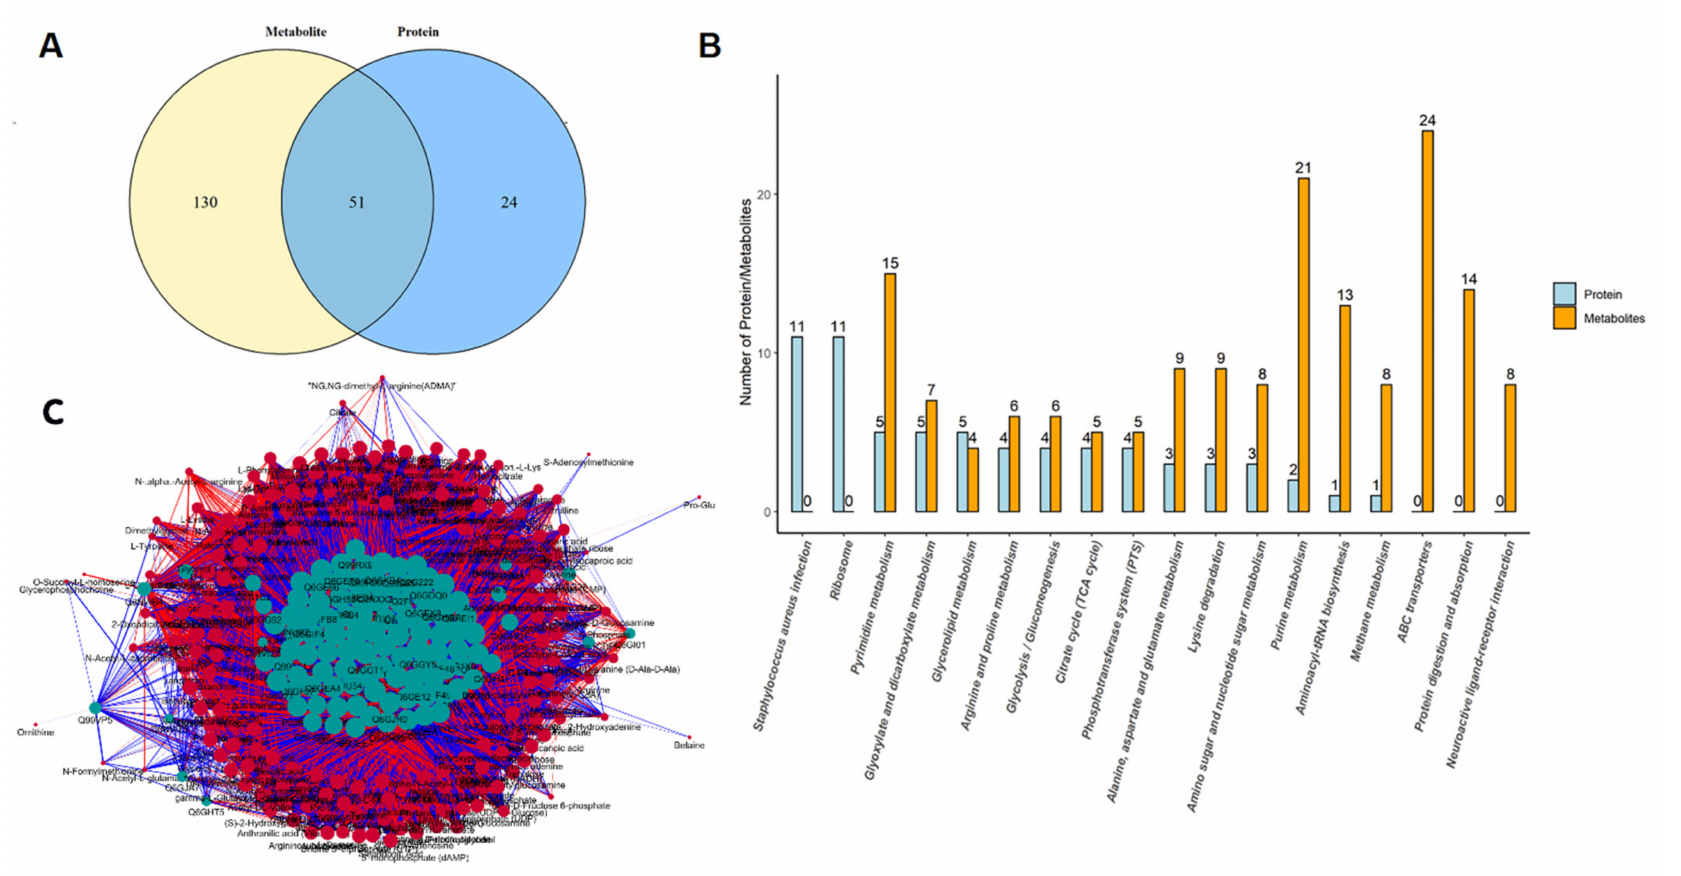
Figure 5. Proteomics–metabolomics correlation network in S.aureus treated with actinomycin D. ( A ) Venn diagram of the differentiated proteins and metabolites. ( B ) Top 18 pathways with the largest number of differentiated proteins and metabolites. ( C ) Network of the differentiated proteins and metabolites. Blue represents proteins, orange represents metabolites, the abscissa text represents the name of the pathway, the ordinate represents the number of differential proteins and metabolites